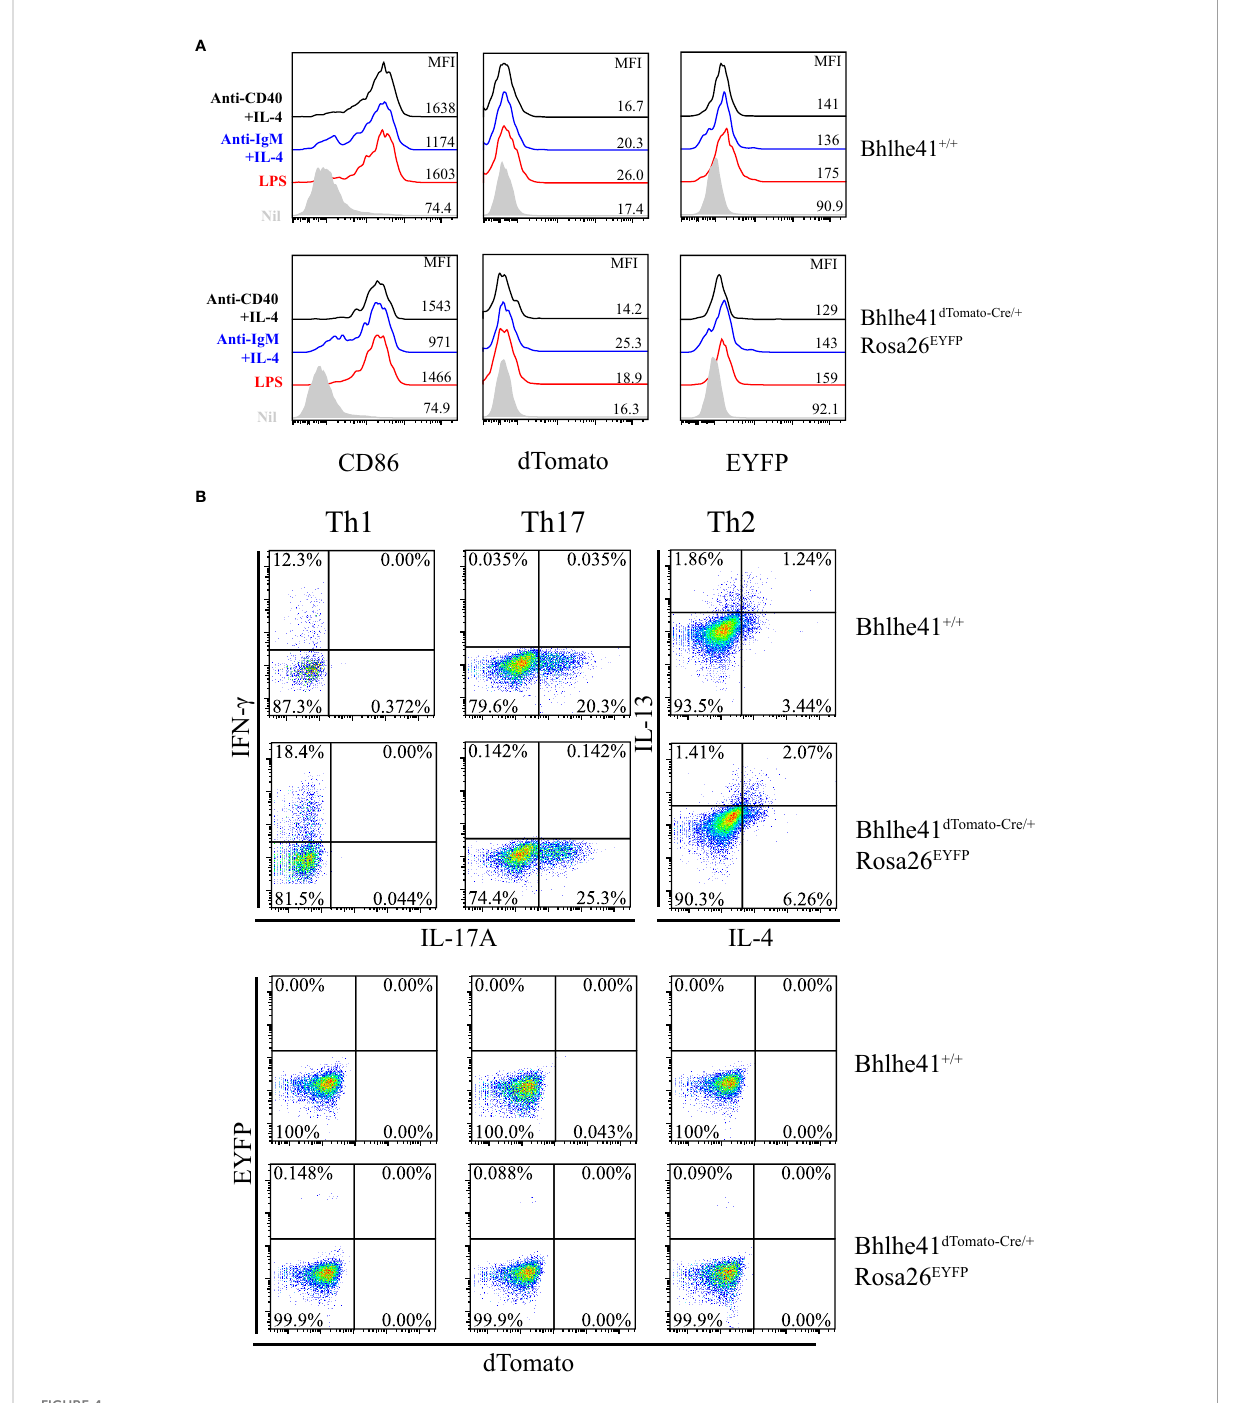
FIGURE 4 In vitro – activated follicular B cells and differentiated Th2 cells do not express Bhlhe41 and are not targeted by Bhlhe41 dTomato-Cre mouse. (A) EYFP - follicular B cells (B220 + CD43 - ) were puri fi ed from Bhlhe41 +/ + and Bhlhe41 dTomato-Cre/ + Rosa26 EYFP mice and in vitro cultured with LPS, anti-IgM plus IL-4, and anti-CD40 plus IL-4, respectively. EYFP, dTomato, and CD86 were assayed by fl ow cytometric analysis. (B) EYFP - naïve CD4 + T cells (CD4 + CD25 - CD62L + CD44 - ) were puri fi ed from Bhlhe41 +/ + and Bhlhe41 dTomato-Cre/ + Rosa26 EYFP mice and in vitro polarized toward Th1, Th2, and Th17 subsets. EYFP and dTomato were directly examined by fl ow cytometric